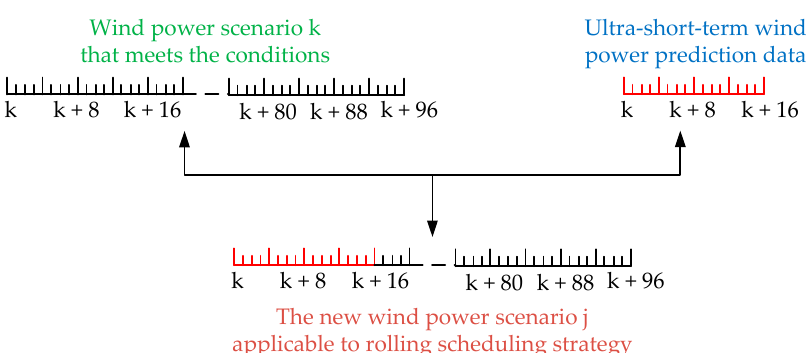
Figure 4. The intra-day wind power scenario generation method.